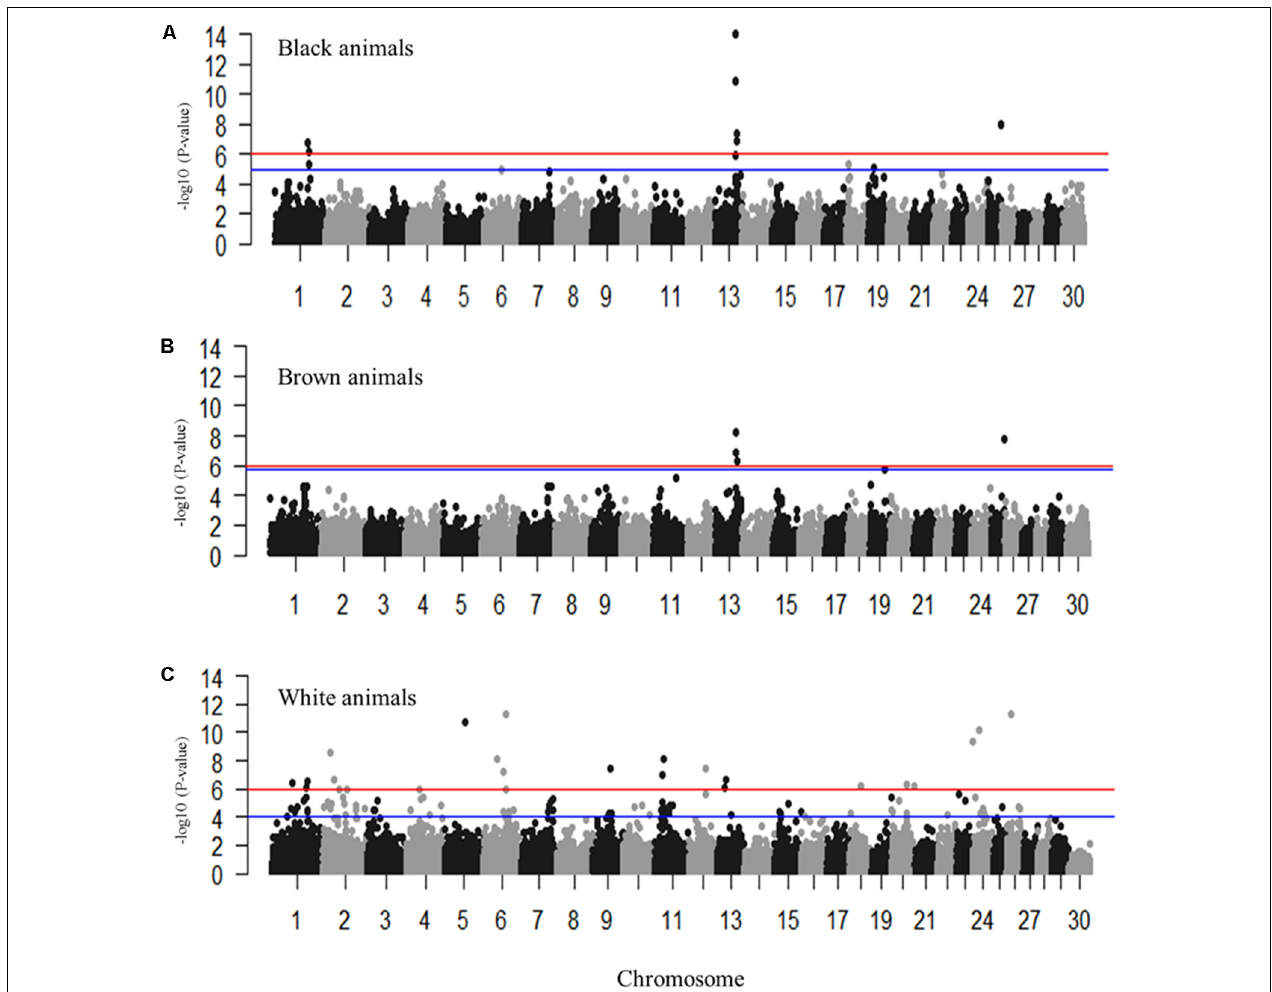
FIGURE 3 | Manhattan plots for the coat colors of black, brown and white in Markhoz goats. (A) Black coat color contrasted to all non-black coat colors. (B) Brown coat color contrasted to all non-brown coat colors. (C) White coat color contrasted to all non-white coat colors. The red and blue horizontal lines indicate Bonferroni and FDR corrected P -values of 0.05,